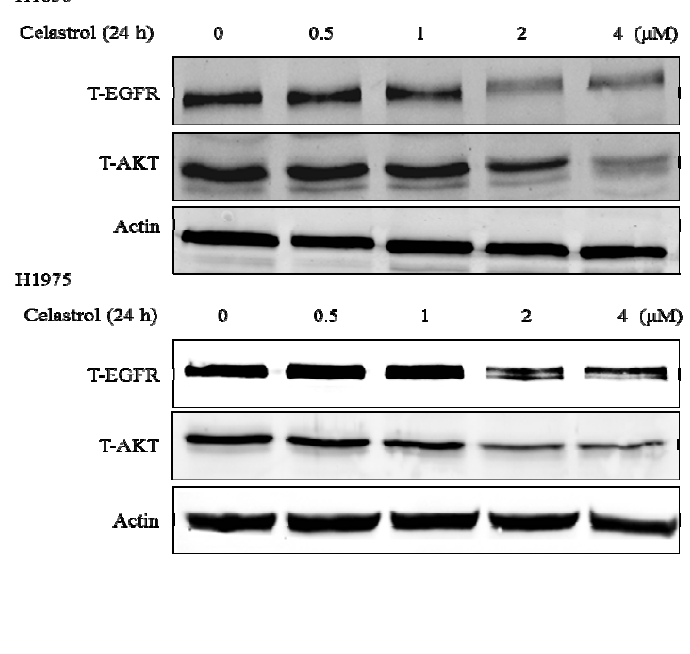
Figure 6. Celastrol significantly induced the degradation of Hsp90 client proteins: EGFR and AKT in both H1650 and